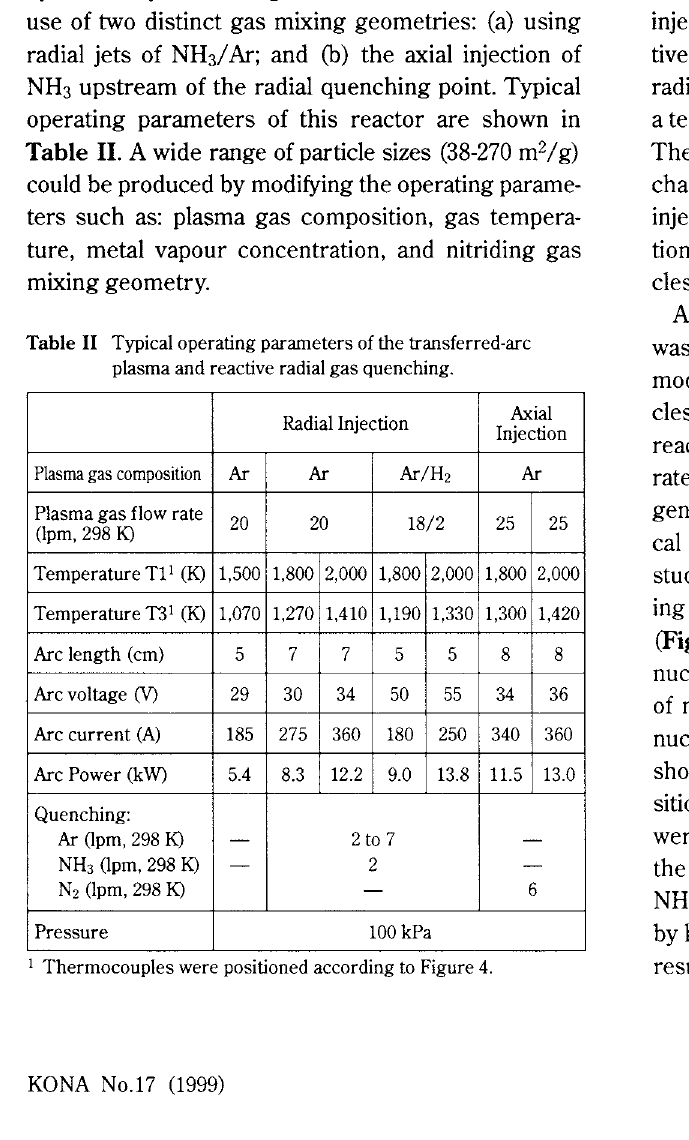
Fig. 4 Schematic diagram of the modified version of the two-stage transferred arc reactor for the syn thesis of AJN ultrafine powder: a) radial injection of NH3; and b) axial injection of NH3. After